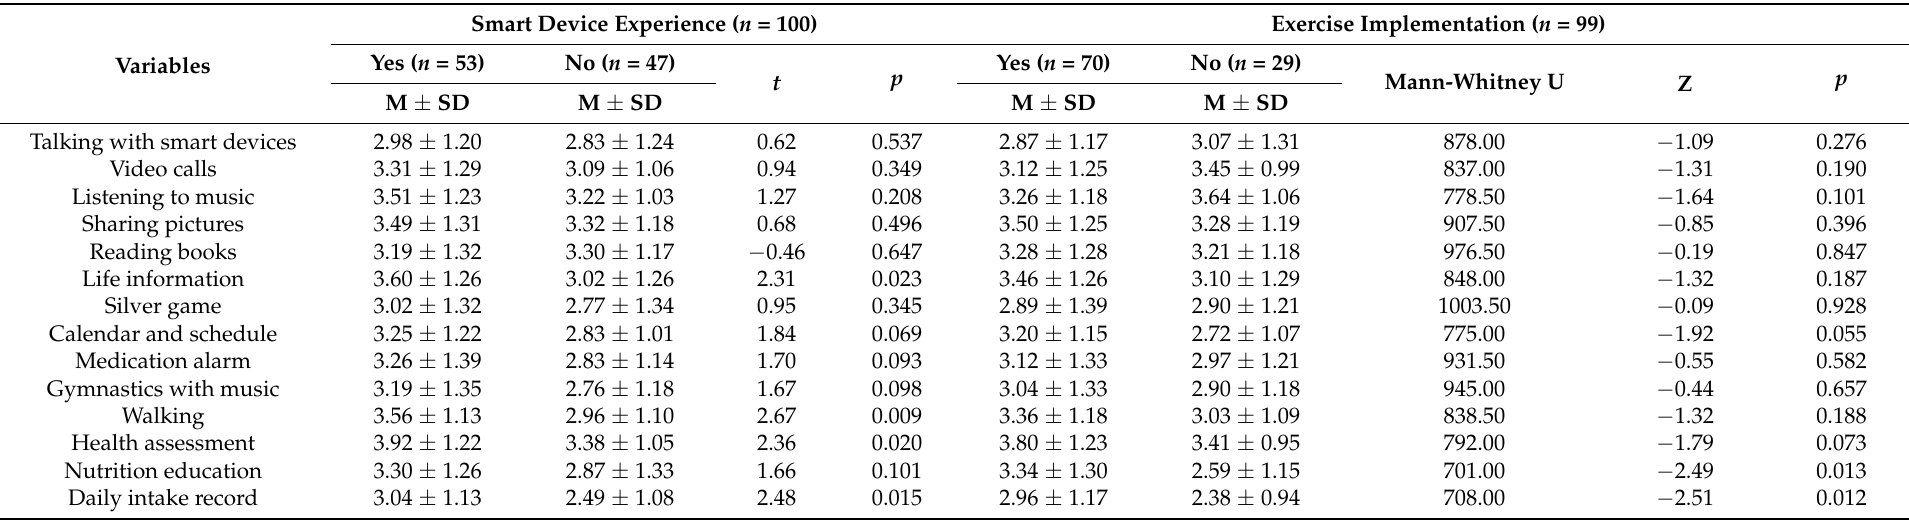
Table 5. Differences in preference related to non-face-to-face services according to smart device experience and exercise implementation (N =